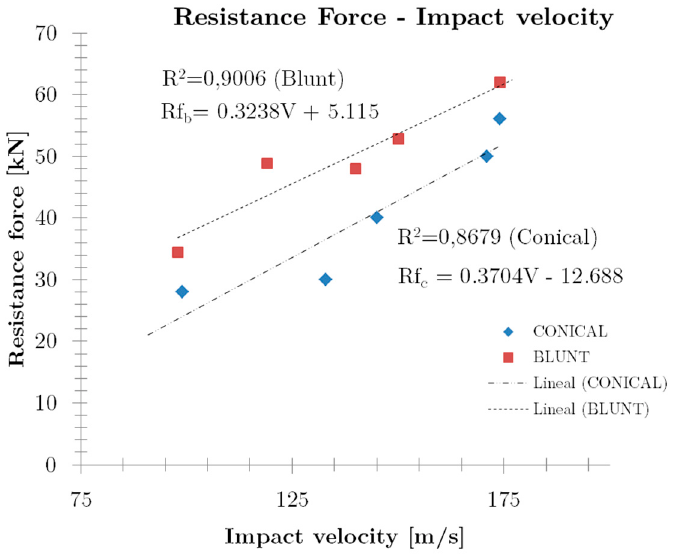
Figure 9. Impact velocity and resistance force comparison for both projectiles.